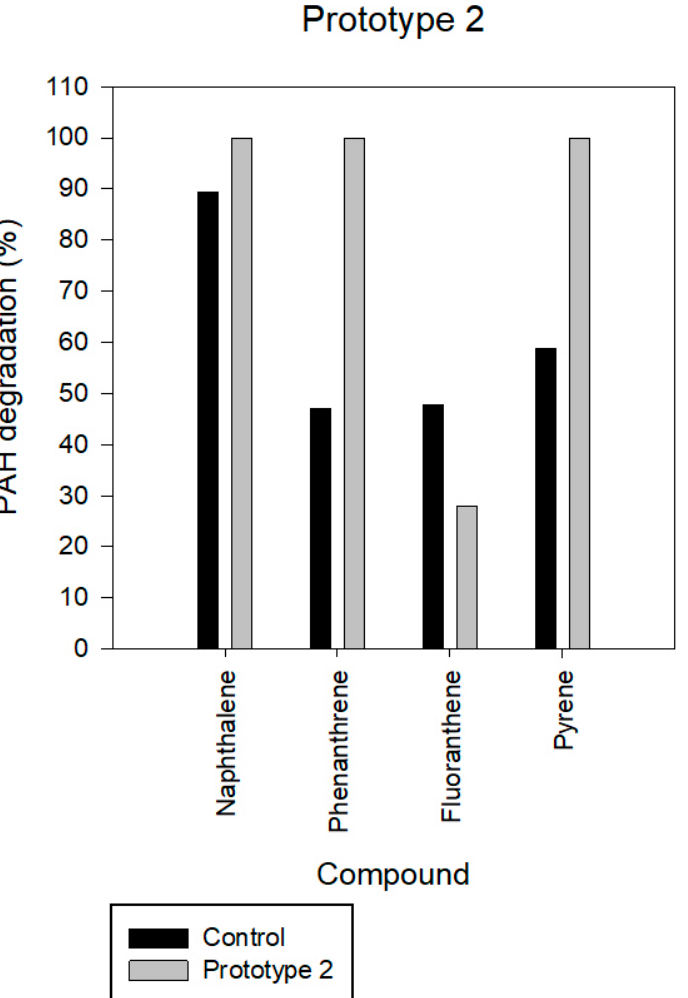
Figure 5. Polycyclic aromatic hydrocarbon (PAH) degradation (%) using prototype 2 versus the control system after 74 days. n = 1.